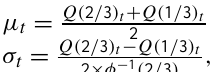
Fig. 6. Plot of χ 2 distances between theoretical and em- pirical distributions of Probability Integral Transform, w.r.t. horizon, for Best Member Method (BMM) and BMM with error modeling using quantile regression (BMM with QR).